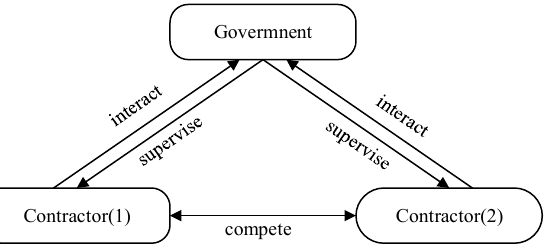
Figure 5. Multi-player game model of construction safety investment supervision.